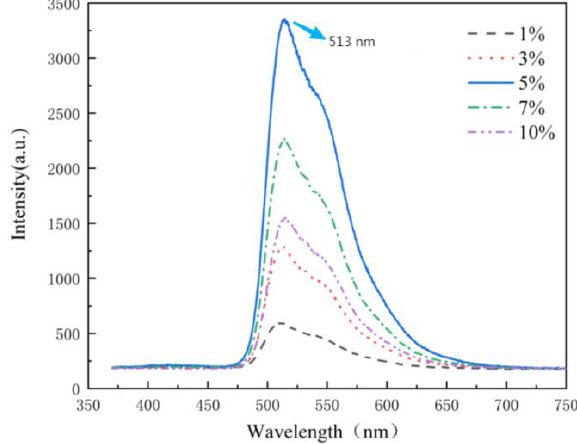
Figure 2. Normalized photoluminescence spectra of PVK: Ir(ppy) 3 with different doping rates.